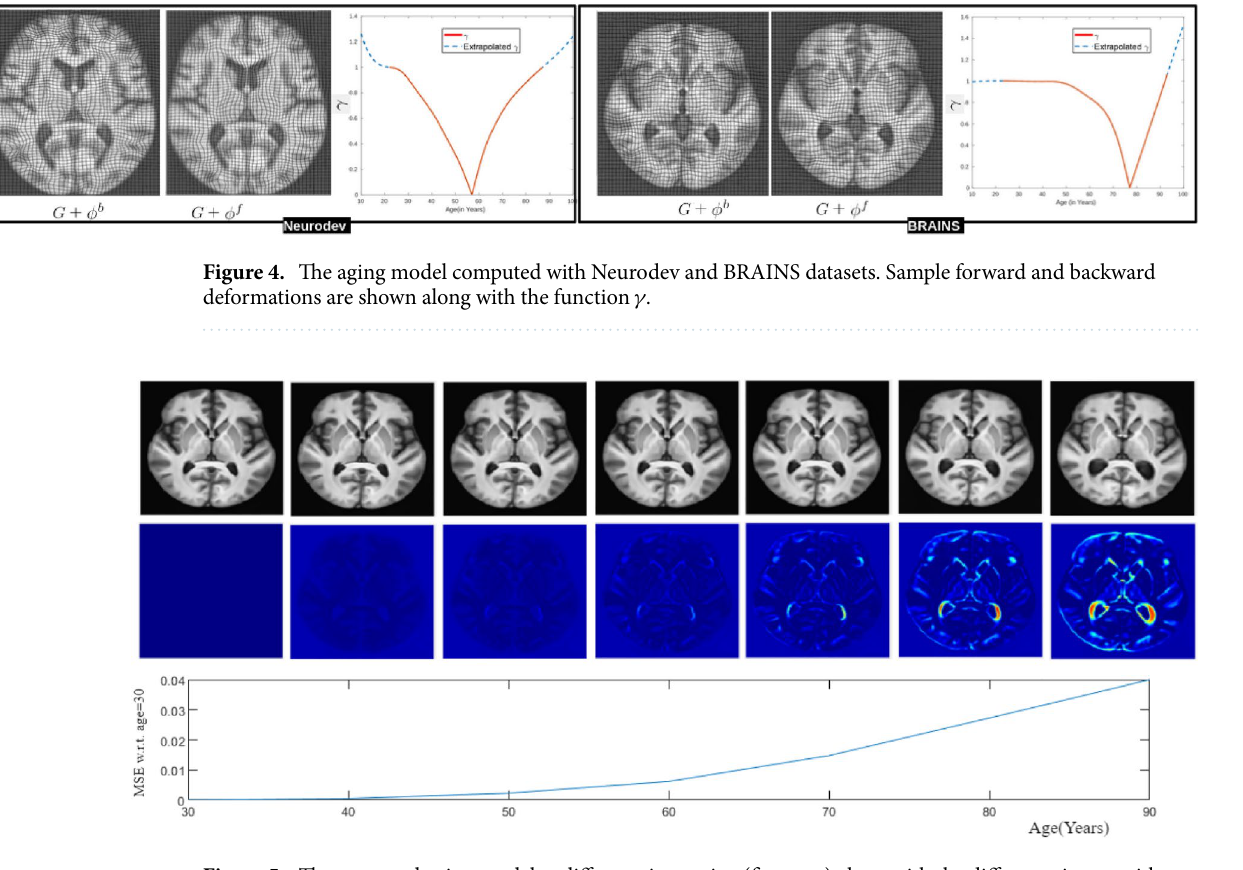
Figure 5. The proposed aging model at different time points(first row) along with the difference image with respect to the initial time point (second